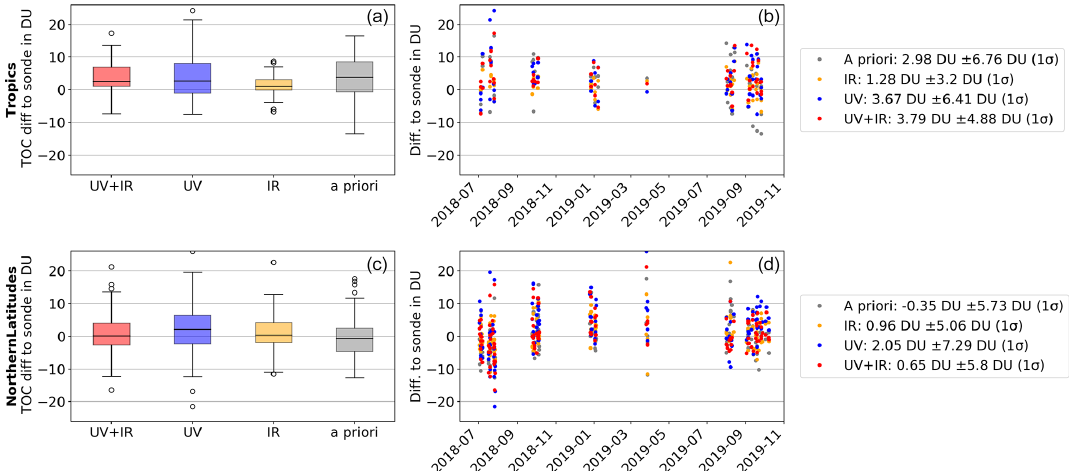
Figure 10. Comparison of TOC with box-and-whisker plots, time series, and statistical information similar to the tropospheric lidar com- parisons shown in Fig. 6. Panels (a) and (b) show the absolute differences in TOC with respect to the ozonesonde data in the tropics (20 ◦ S–20 ◦ N). Panels (c) and (d) are the same as the upper panel but for the northern latitudes (20–60 ◦